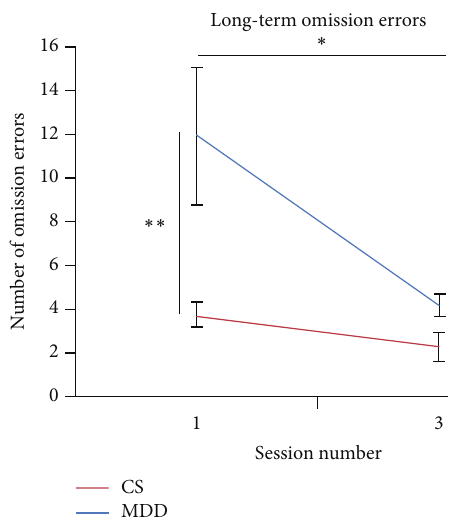
Figure 3: Adjusted group means and standard errors of omission errors from the Sustained Attention to Response Task across Sessions 1 and 3 for clinically diagnosed Major Depressive Disorder (MDD) patients and control subjects (CS). The significance differ- ences reported relate to the post hoc analysis of interaction effects, ∗ 𝑝 < 0.05 , ∗∗ 𝑝 < 0.01